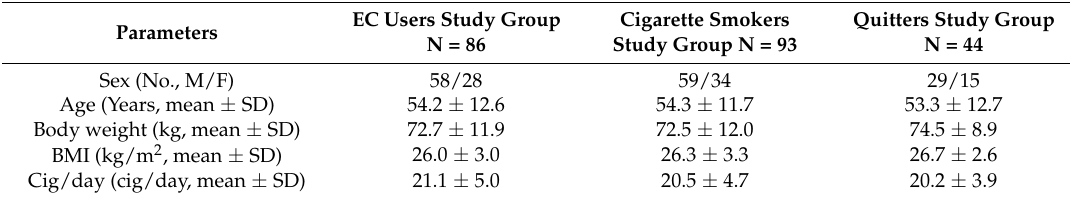
Table 1. Subjects’ characteristics at baseline